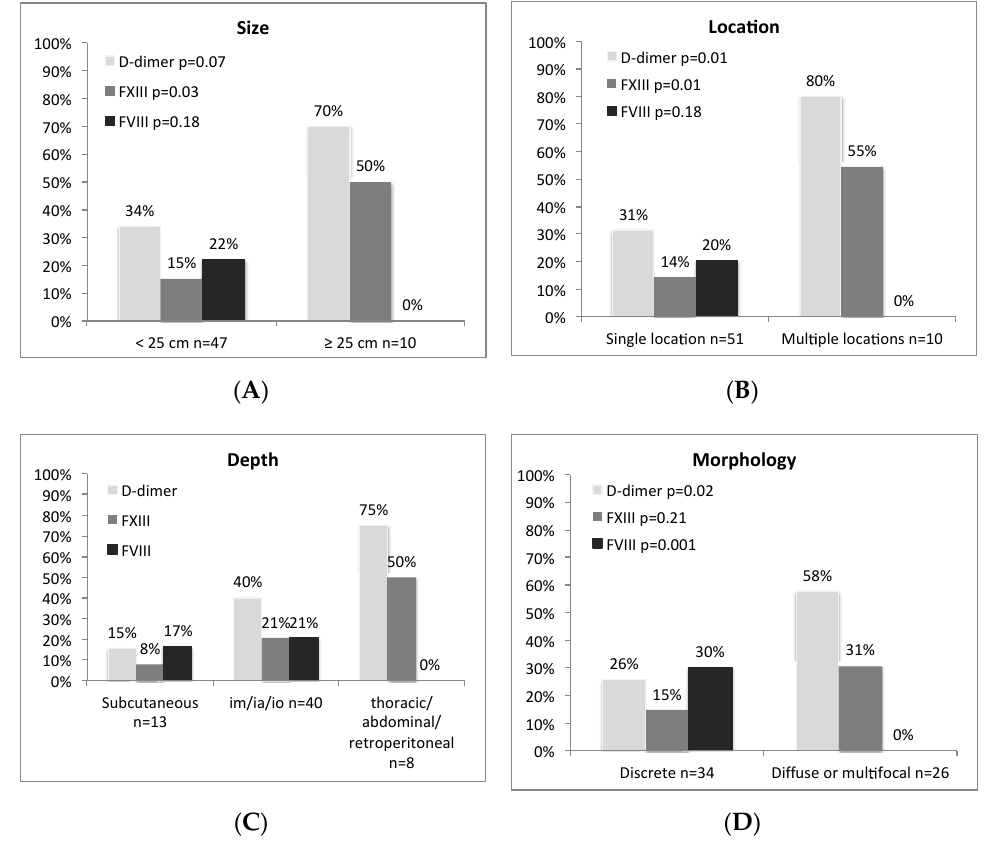
Figure 4. Associations between coagulation variables and clinical and imaging findings. The columns indicate the percentage of patients whose coagulation variables were outside the reference limits (elevated FVIII > 148 IU/dL, decreased FXIII < 76 IU/dL, and elevated D-dimer ≥ 0.5 mg/L). ( A ) Lesion size; comparison of the largest size group (>25 cm) with the smaller size group. ( B ) Lesion location; single location lesions are limited to one location (head/neck, extremities, or trunk), multiple locations extend to more than one location or indicate multiple lesions in different locations. ( C ) Lesion depth; a comparison between 1. subcutaneous, 2. muscle-, joint-, and/or bone-affecting, and 3. intrathoracic, intra-abdominal, or retroperitoneal lesions. The p -values are non-applicable in C due to too small groups for the Chi-square test. ( D ) MRI-based morphology; comparison between discrete, well-demarcated lesions and diffuse or multifocal lesions.